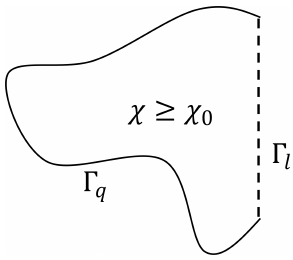
Figure B1. An example of the area enclosed by the isopleth of χ and a specific longitude. (cid:48) q is the part of the isopleth χ = χ 0 . (cid:48) l is the part of the circle of longitude λ = λ 0